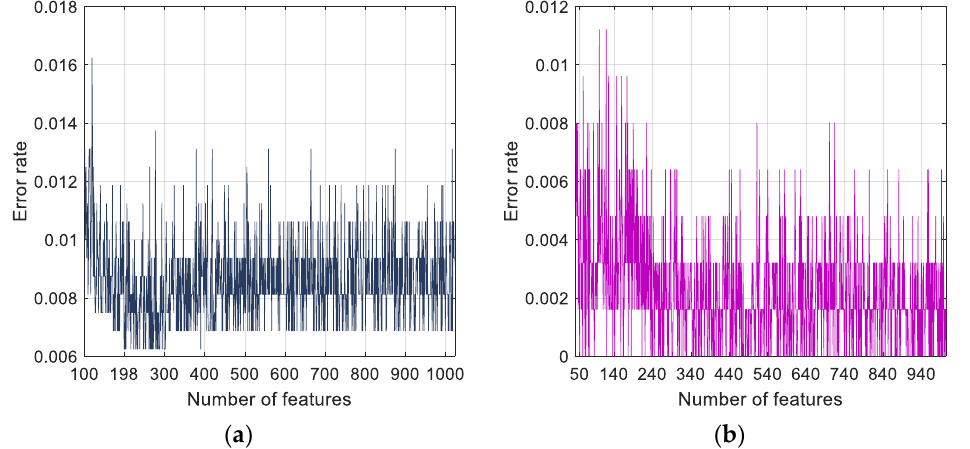
Figure 7. Plots of error rates versus number of features selected by ImRMR for ( a ) Case 1 and ( b ) Case 2.